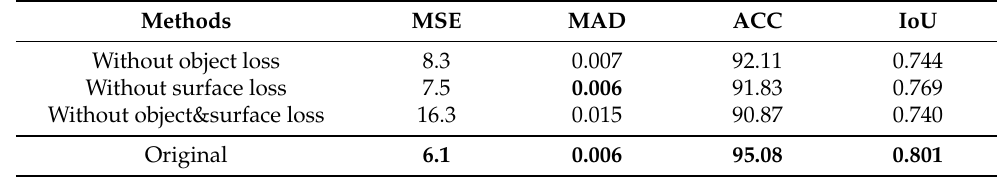
Table 4. Variants of the proposed method (with depth noise and pose